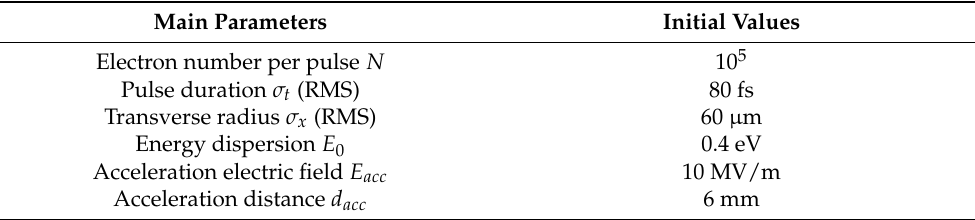
Table 1. Main parameters and initial values. Main